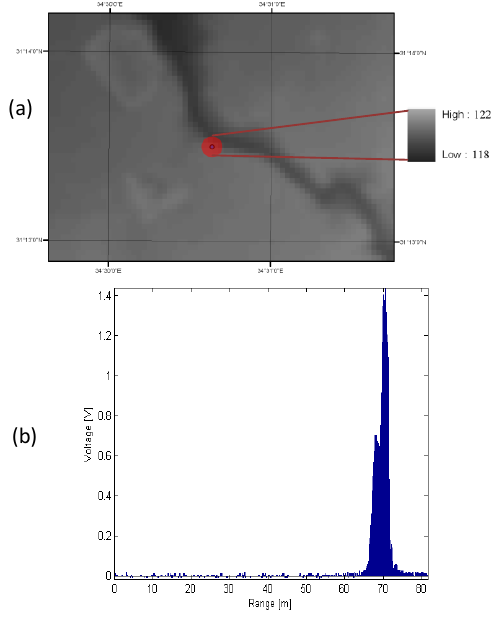
Figure 5. 3D view of DEM (a) and the waveform (b) at the location of the GLAS